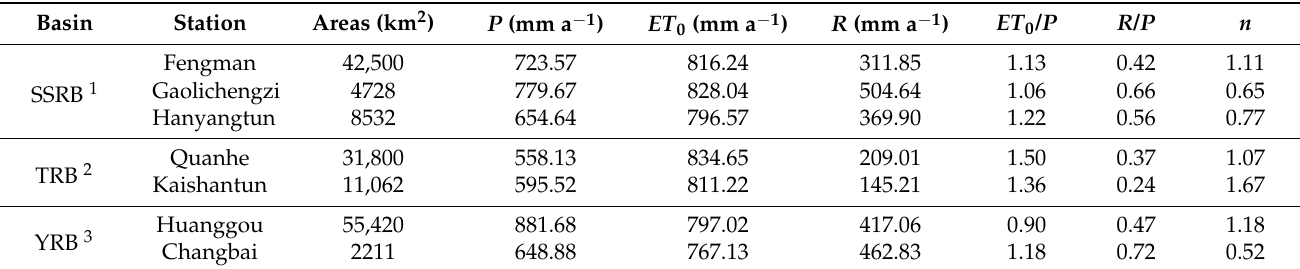
Table 2. Basic hydroclimatic characteristics of the Changbai Mountain area. Basin Station